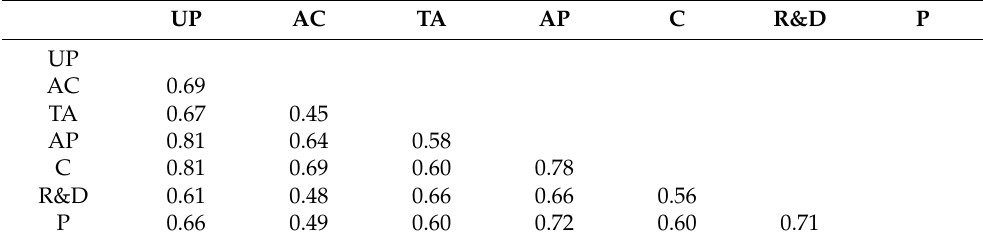
Table 4. Discriminant